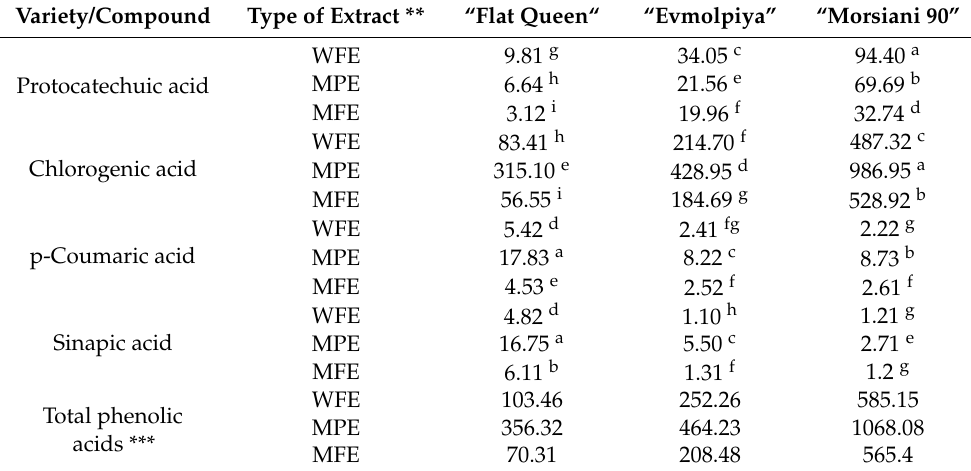
Table 6. Phenolic acid content * ( µ g/g fw) of late season peach ( Prunus persica L.) varieties. Variety/Compound Type of Extract ** “Flat